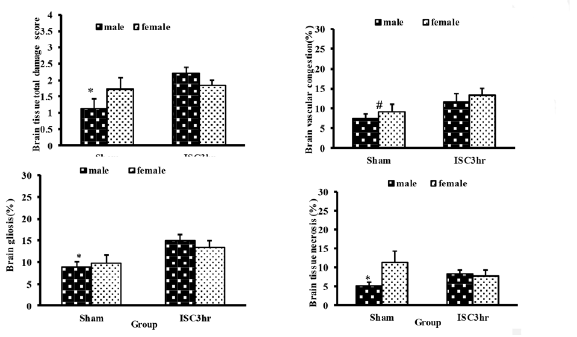
Figure 3. Comparison of Total Brain Tissue Damage, Cerebral Venous Congestion, Gliosis, and Necrosis of Brain Tissue in Both Male and Female Groups During ischemia-reperfusion. Data were reported as mean ± SEM. # indicates significant difference between sham and ischemia groups in both genders. * indicates significant difference ( P < 0.05) between sham and ischemia groups in male rats. P- values were derived from Kruskal- Wallis